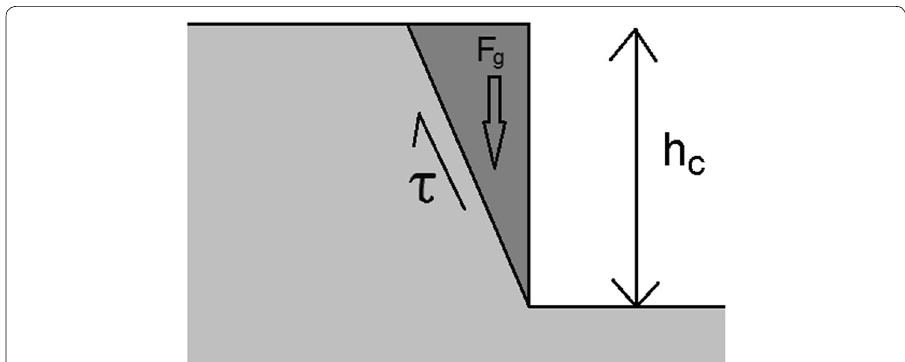
Fig. 6 Definition sketch for determining the cohesive height, h c . Fg is the weight of the sliding element and τ is the cohesive shear stress